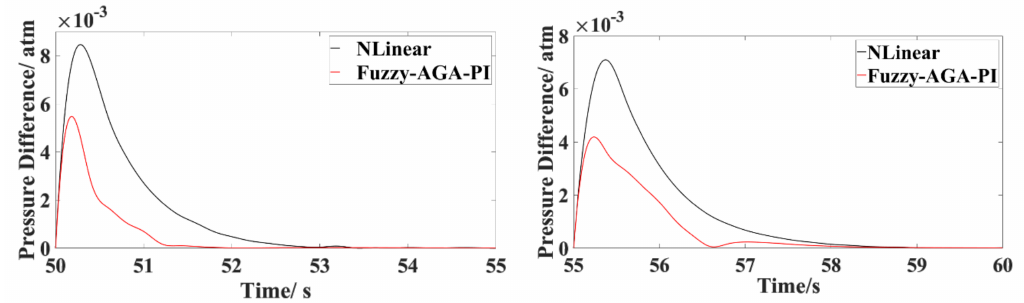
Figure 10. Two moments of large changes in the